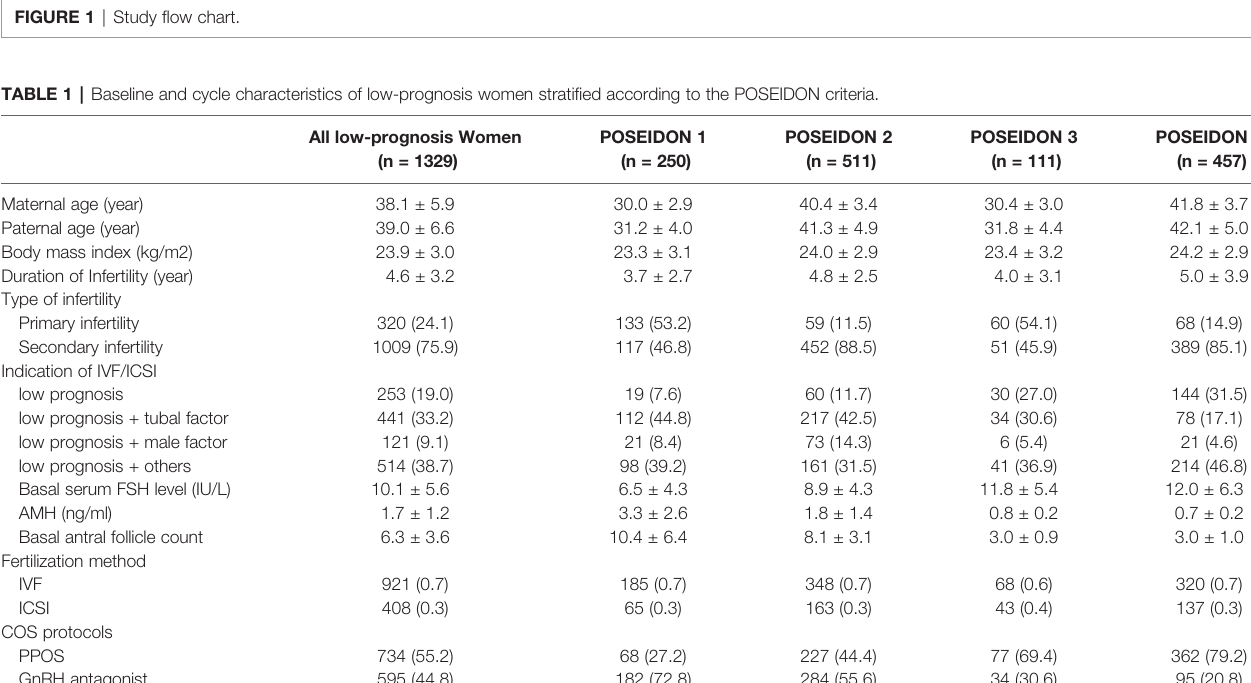
Data are presented as the mean ± SD for continuous variables and n (%) for categorical variables. COS, controlled ovarian stimulation; PPOS, progestin-primed ovarian stimulation.